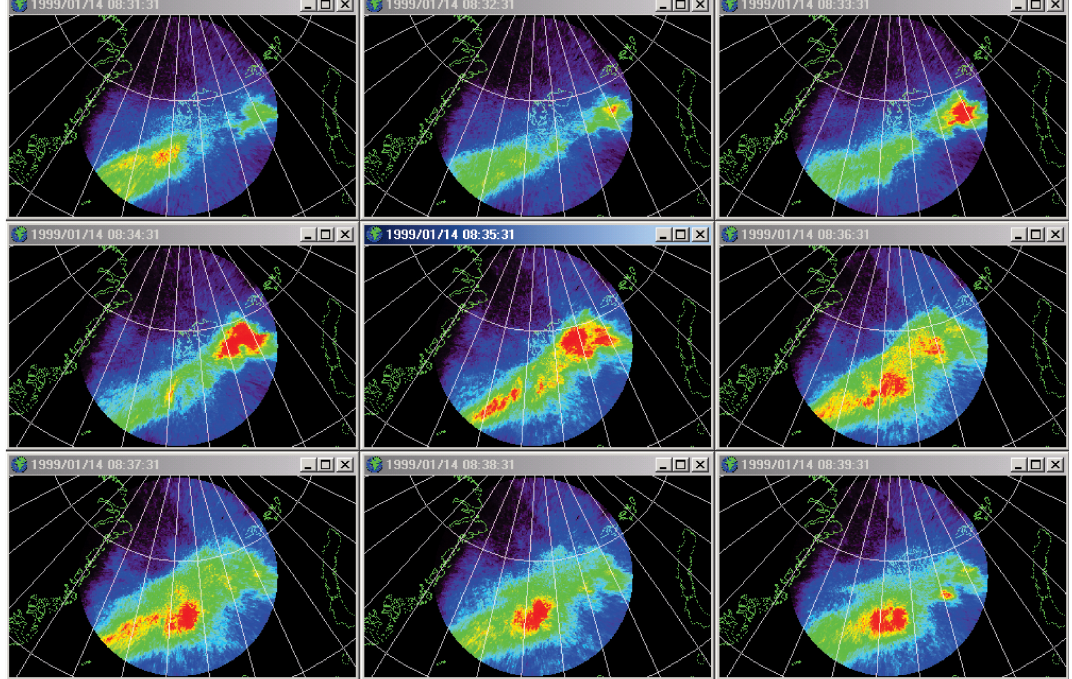
Fig. 5. Ny ˚Alesund all-sky camera images at 630.0nm taken at 08:31:31; 08:32:31; 08:33:31; 08:34:03; 08:35:31; 08:36:31, 08:37:31, 08:38:31, and 08:39:31UT. Each image is projected to an altitude of 250km and shown on the background of a geographic coordinate system. The 70 ◦ and 80 ◦ latitude circle and meridians separated by 10 ◦ are